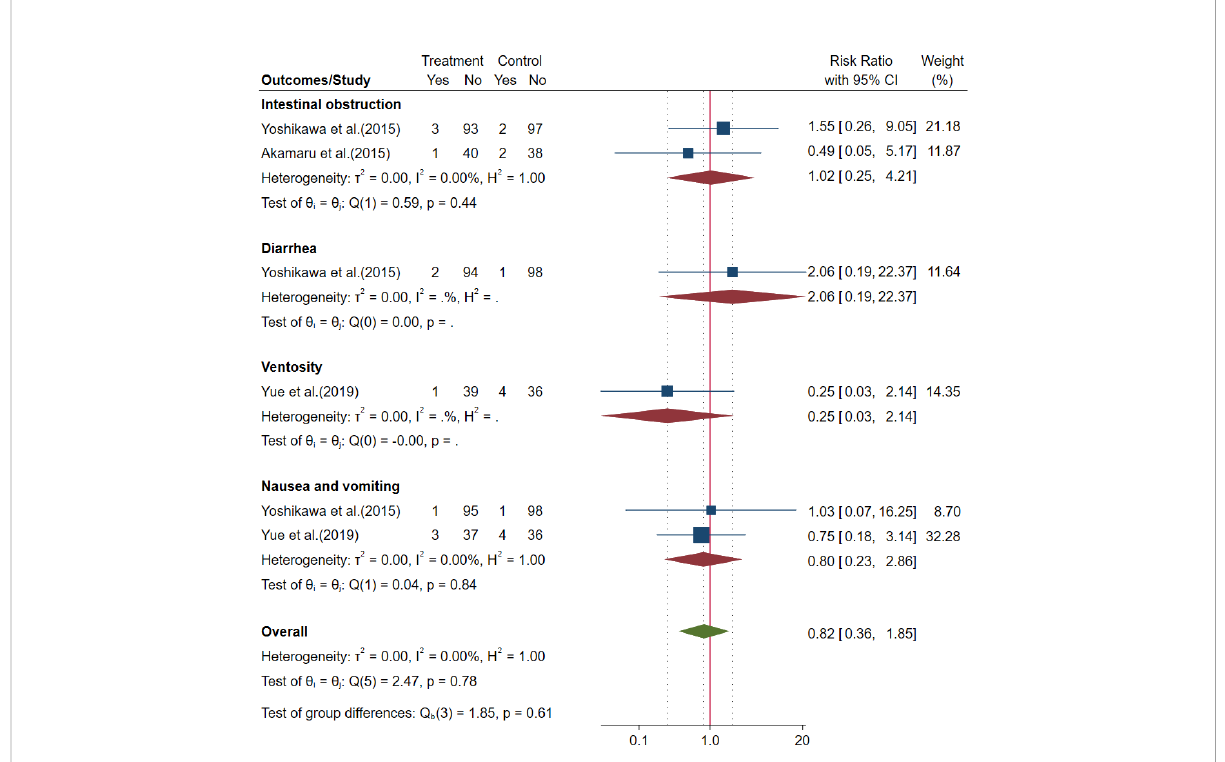
FIGURE 4 Forest plot of adverse events (AEs) in perioperative gastric cancer